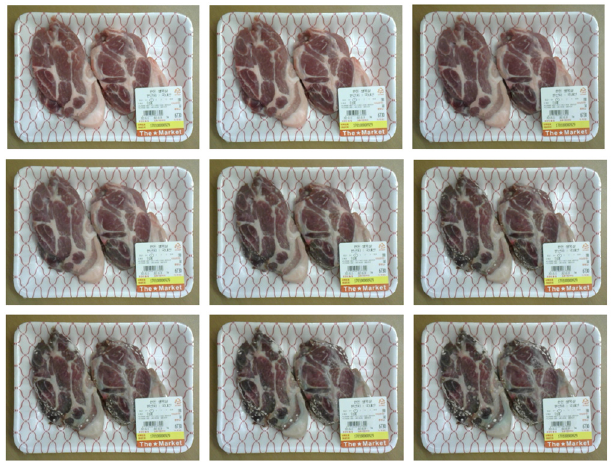
Figure 10. Pork measured through the